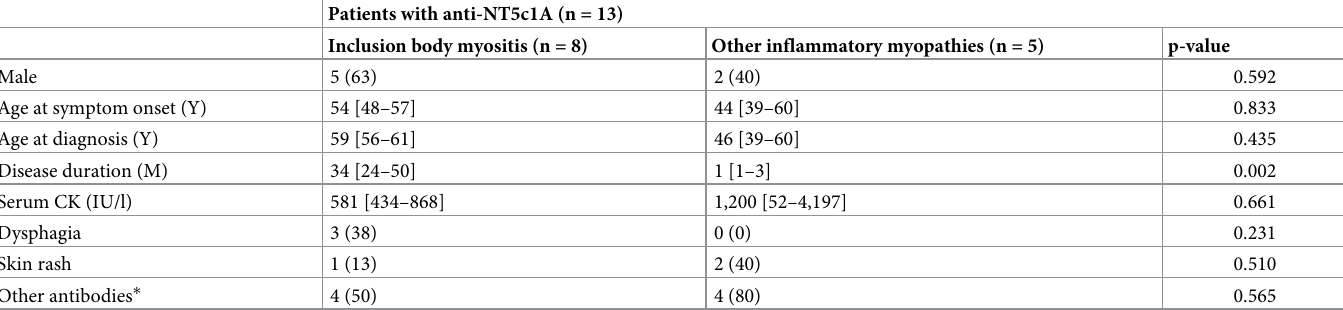
Table 4. Comparison of clinical features between inclusion body myositis (IBM) and non-IBM inflammatory myopathies with anti-NT5c1A